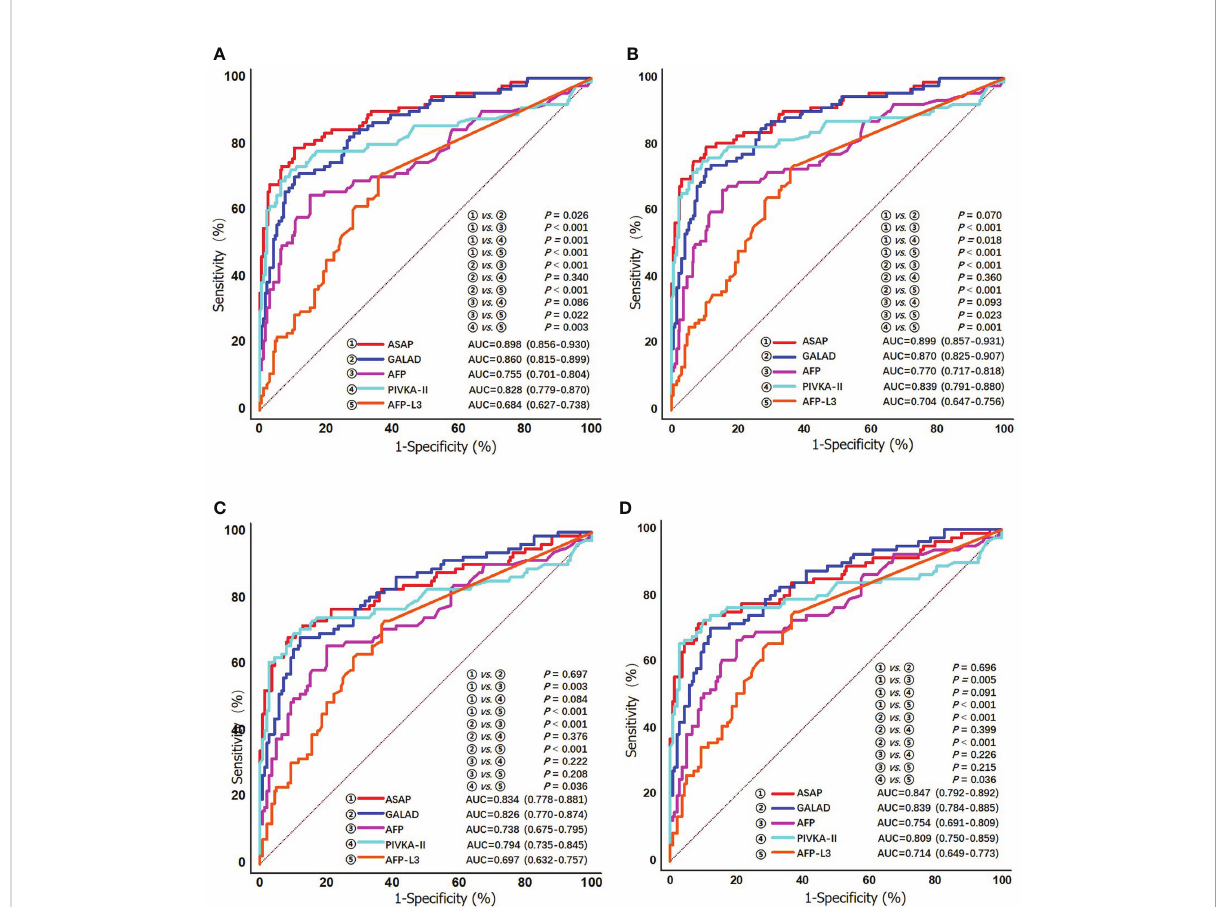
FIGURE 4 ROC curves of the ASAP score, the GALAD score, AFP, PIVKA-II, and AFP-L3% for detecting early stage HCV-HCC in the overall group (A) BCLC stage 0/A; and (B) TNM stage I; and in the cirrhosis subgroup (C) BCLC stage 0/A; and (D) TNM stage